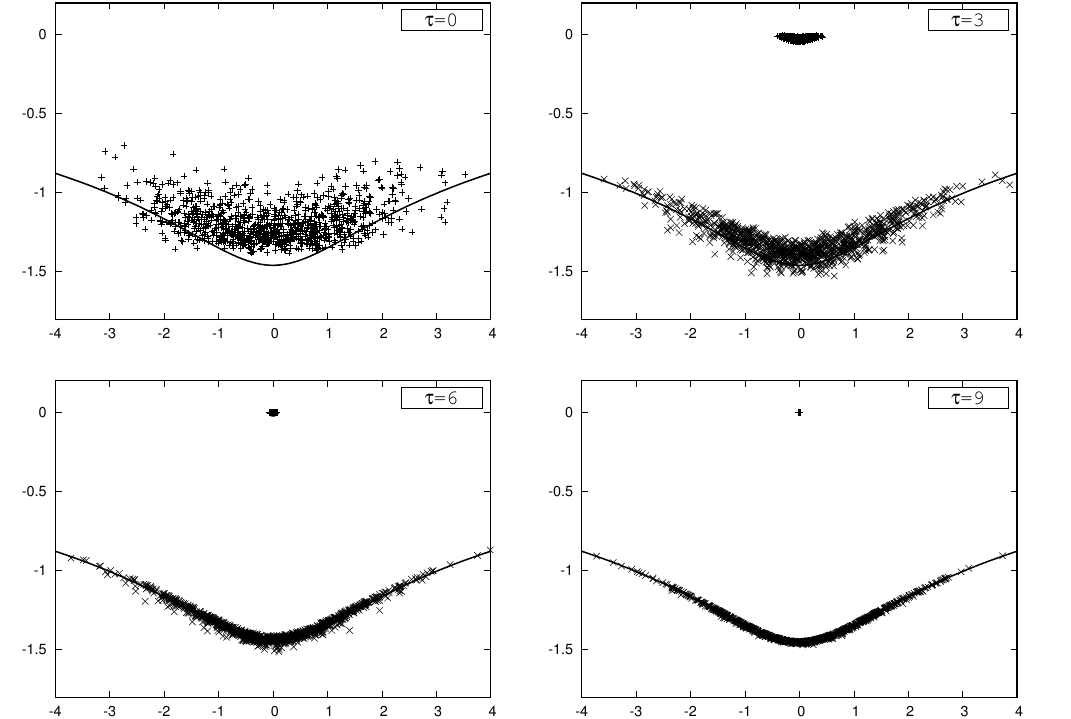
Figure 2 . The distribution of z (represented by \+") and (cid:13)owed con(cid:12)gurations (represented by \ (cid:2) ") obtained by applying the CLM to the partially phase quenched model (4.3) are plotted for (cid:28) = 0 ; 3 ; 6 ; 9 from Top-Left to Bottom-Right. The solid line represents the Lefschetz thimble. At (cid:28) = 0, the distribution of z and (cid:13)owed con(cid:12)gurations coincides.